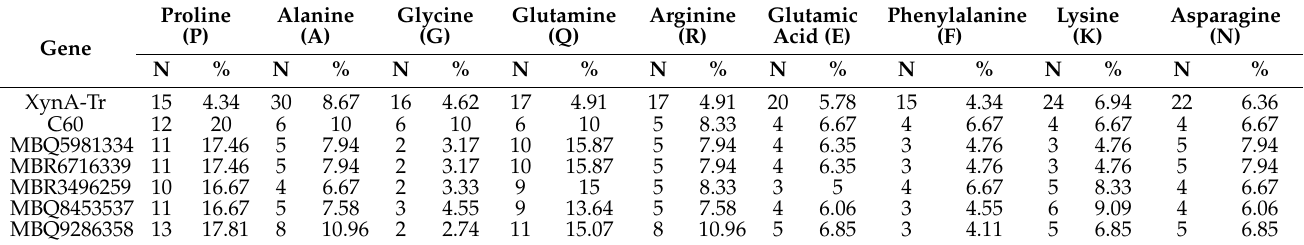
Table 1. Comparison of amino acid contents of different linkers.